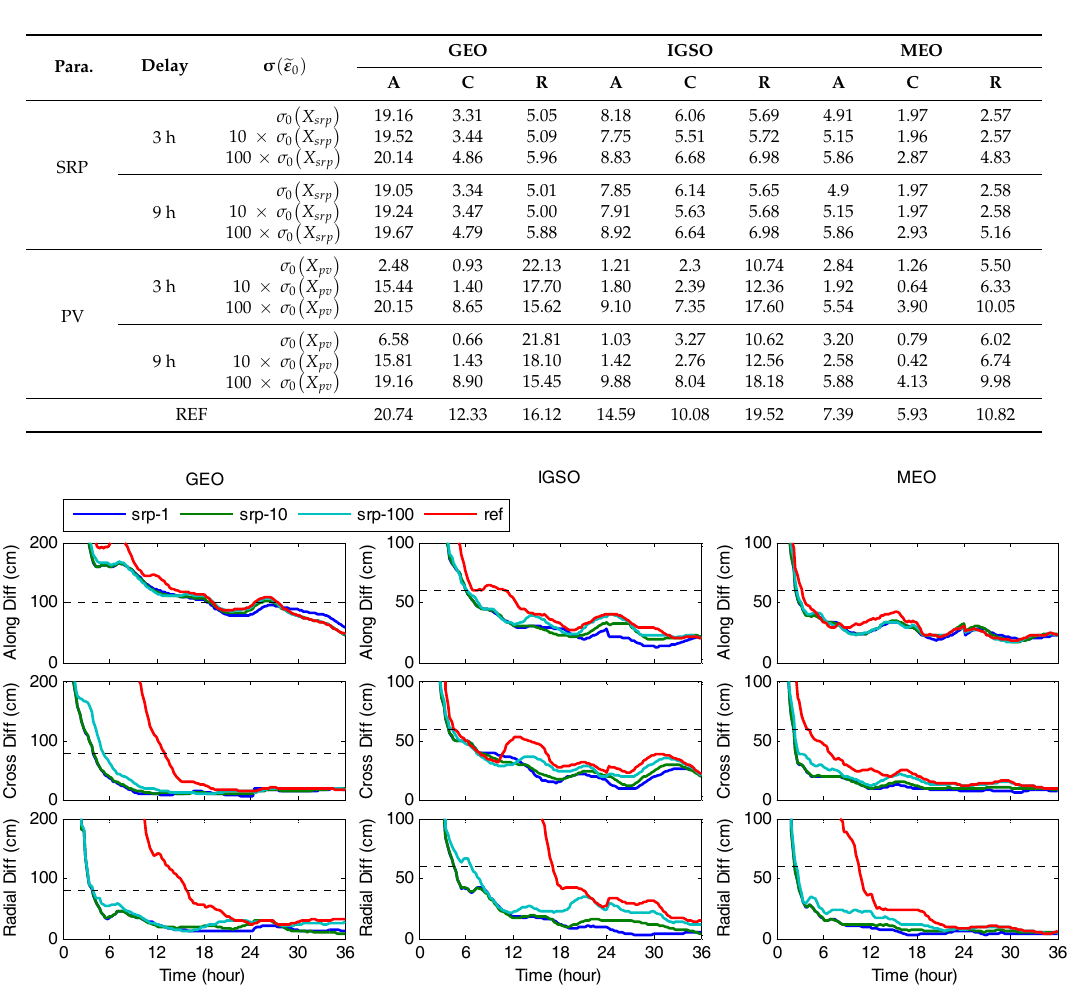
Table 6. The average convergence time of the filter orbit using different a priori STD when the UR product is used as the initial orbit. Both 3-h and 9-h latency are calculated. Unit [hour]. For the GEO satellites, the convergence criteria adopted in our study are 100 cm in the along-track, and 80 cm in the cross-track and radial direction. For the IGSO and MEO satellites, the criteria are 60 cm in three directions.